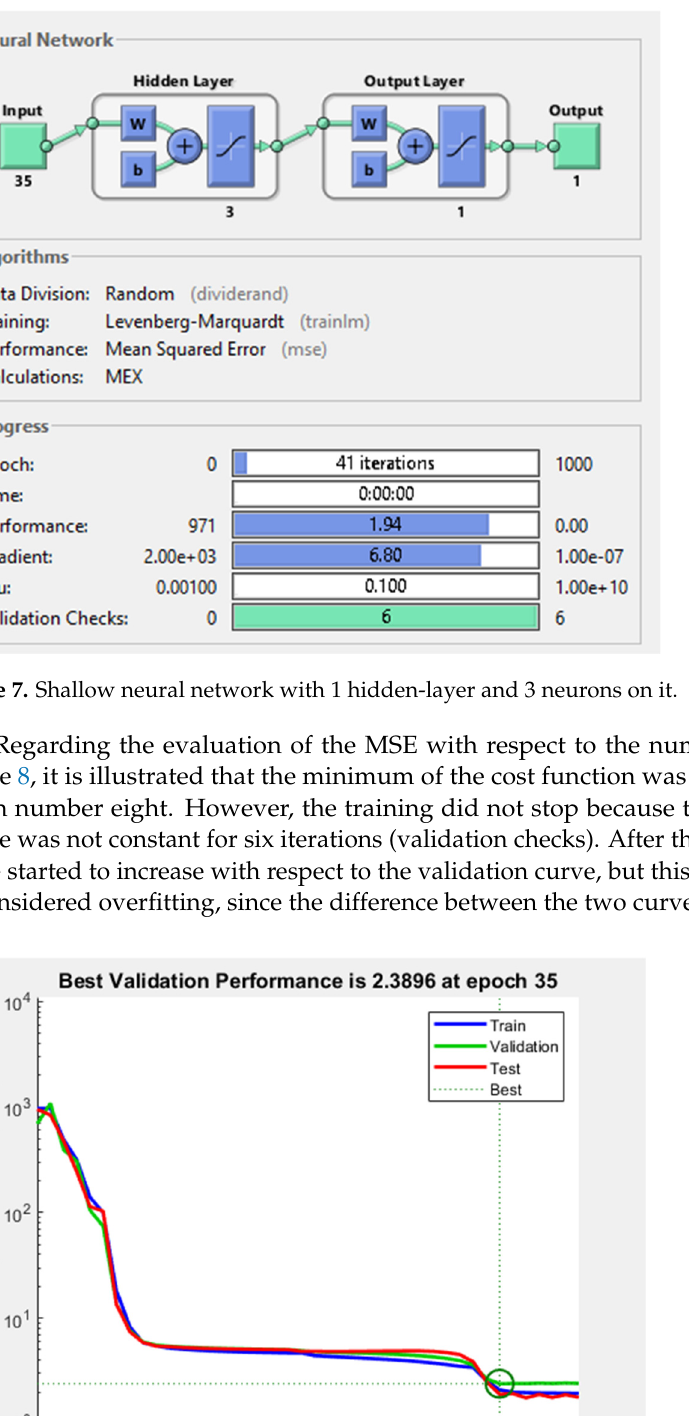
Figure 9. Performance plot the shallow neural network with 1 hidden layer and 10 neurons on it. In the third case, a shallow neural network having 20 neurons was constructed. This network presented the highest MSE among all three shallow neural networks: 3.49. The number of epochs was 32, but the best performance was reached after 26 iterations. The only significantly better performance measure obtained with this shallow neural network was the gradient which had a value of 2.62.